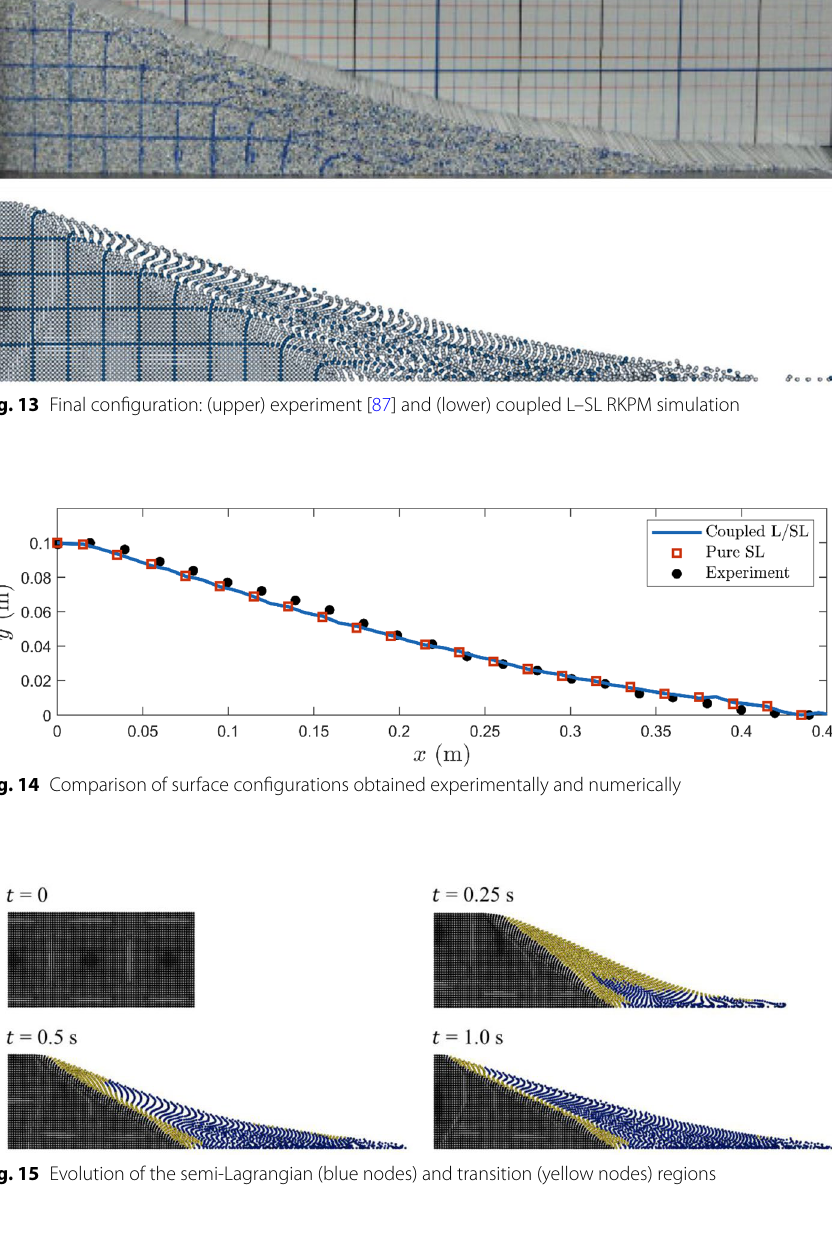
reference solution is apparent in the third, gradual transition case. This illustrates the need for a smooth ramp function such as the one in Eq. (59).